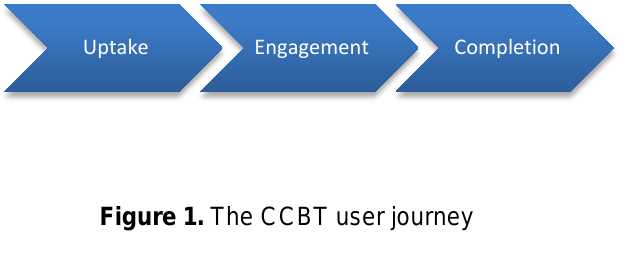
Figure 1. The CCBT user